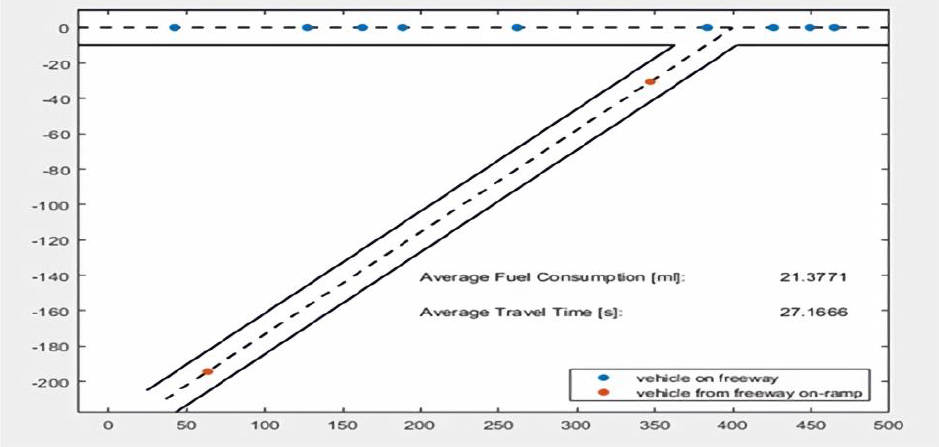
Figure 8. Vehicles moving on the freeway where fuel less fuel consumption, and average less travel time is generated by the travel report.